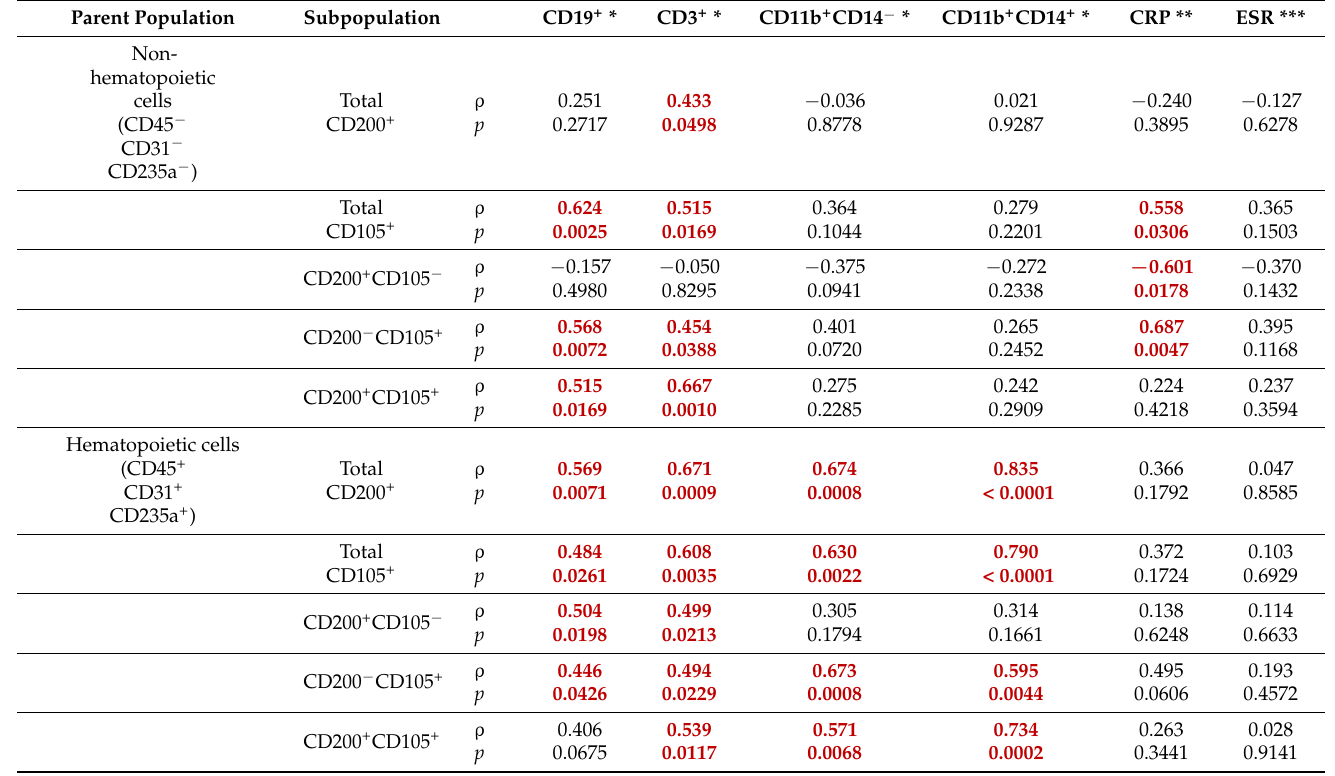
Table 1. Associations of proportions of non-hematopoietic and hematopoietic synovial cells classified according to their expression of CD200 and CD105, with frequencies of major hematopoietic lineages in the synovial tissue and diagnostic markers of inflammatory